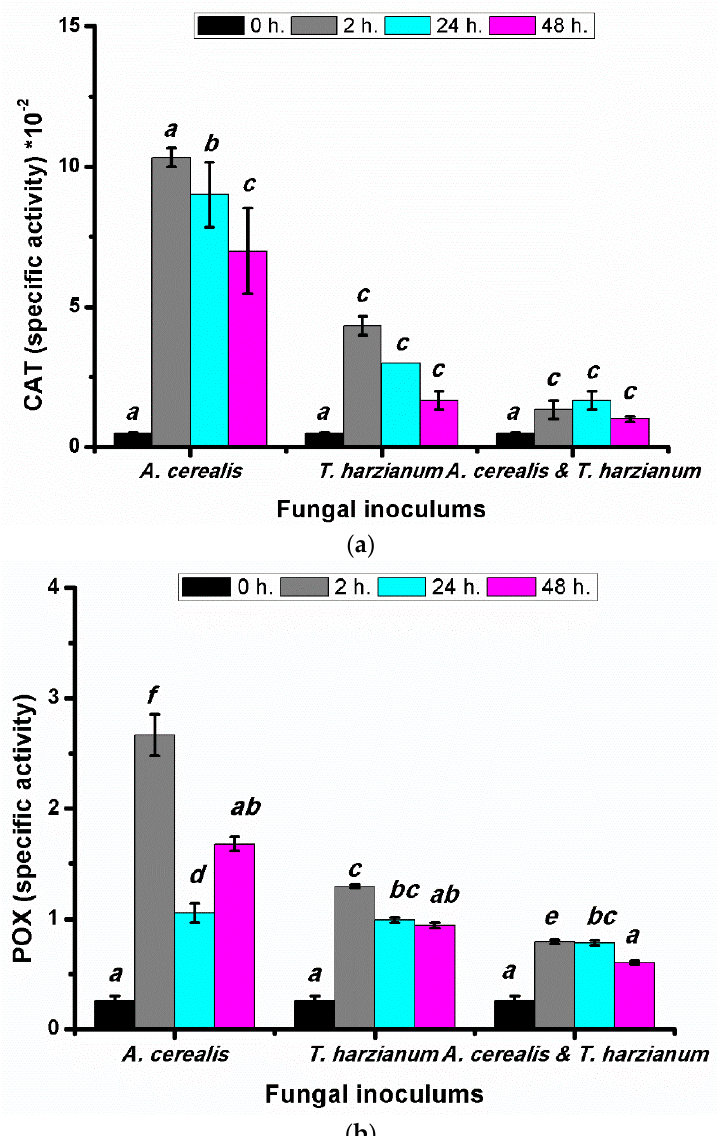
Figure 11. CAT ( a ) and POX ( b ) (specific activity) of tomato leaves ( S. lycopersicum L.) under the effect of pathogen ( Alternaria cerealis MT808477), and pathogen inhibitor ( Trichoderma harizainum ) after 0, 2, 24, 48 h of inoculation, data are means ± SD ( n = 3), with statistically significant differences ( p < 0.05).